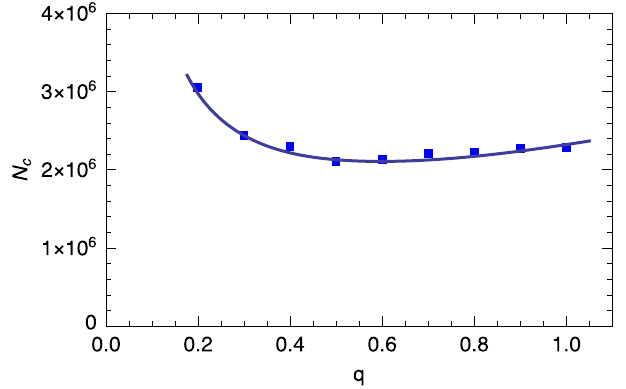
FIG. 5. Cooling time as a function of dimensionless chicane